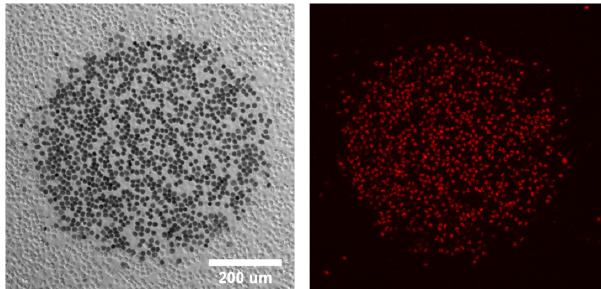
Fig. 1. Dead cells induced by supra-lethal dose of UVA were stained by trypan blue (left; black region) and PI (right; red region). The area of dead cells was about 3 : 36 (cid:1) 10 (cid:3) 3 cm 2